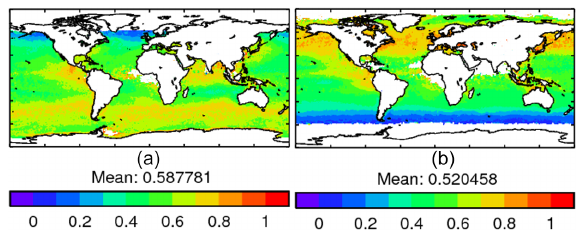
Figure 4. Fine-mode fraction of marine aerosol optical depth at 0.55µm as derived from MODIS/Terra Collection 6 aerosol re- trievals for the months of January (a) and July (b)